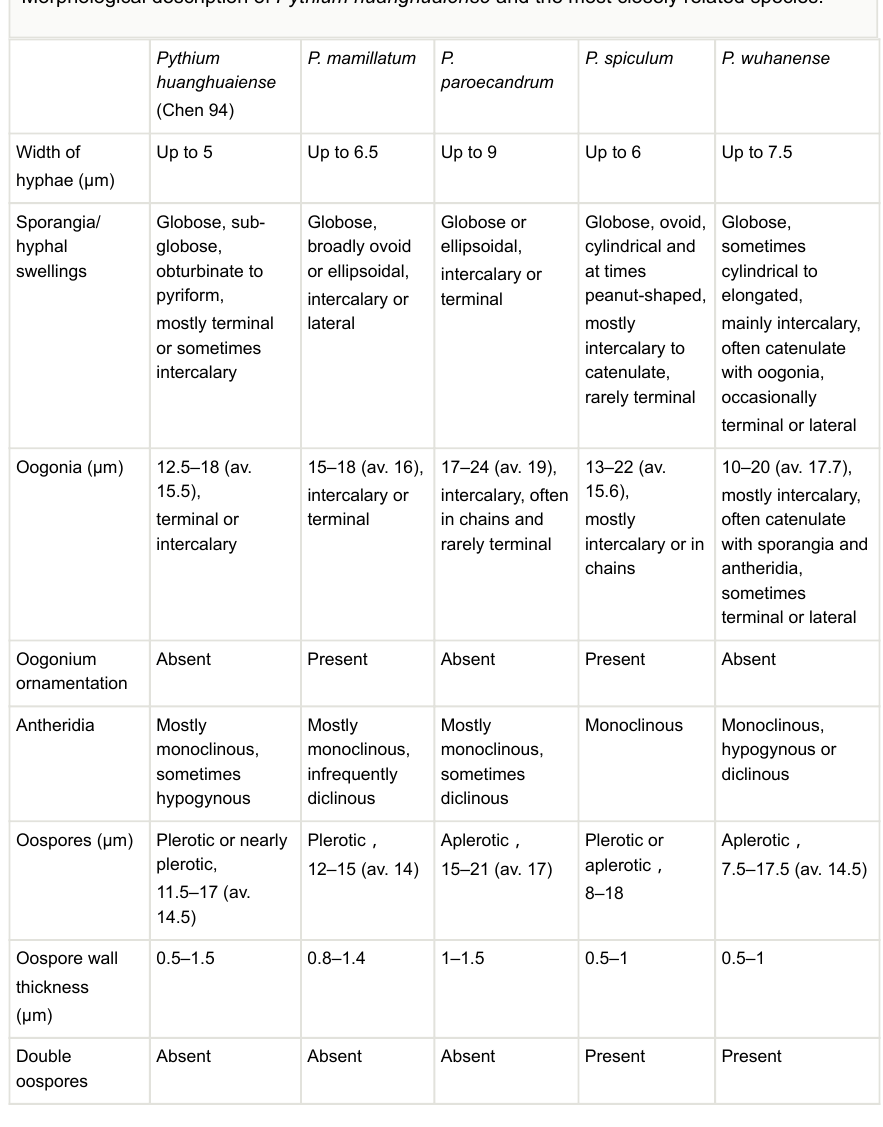
Pythium huanghuaiense can be distinguished morphologically from its closest relatives, including P. mamillatum Meurs, P. paroecandrum Drechsler, P. spiculum B. Paul and P. wuhanense Y.Y. Long, J.G. Wei & L.D. Guo, by its narrower hyphae and relatively higher maximum growth rate. Additional differences between the novel species and other related species are listed in Table 2.